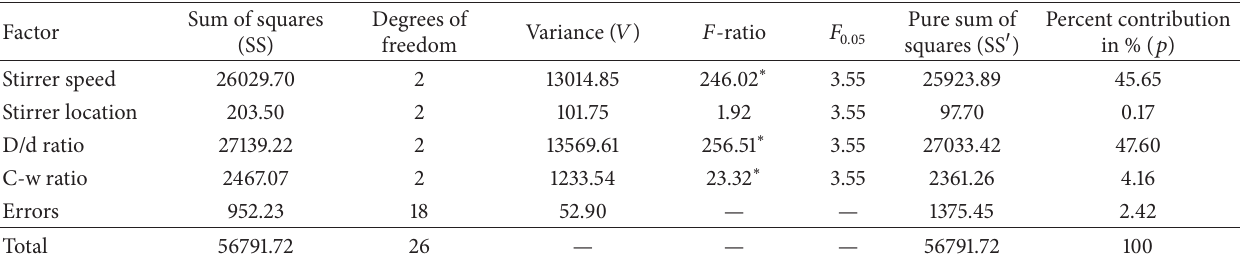
Figure 6: Main effects plots for S/N ratios of coal-water slurry. Table 7: Analysis of variance (ANOVA) for heat transfer coefficient.